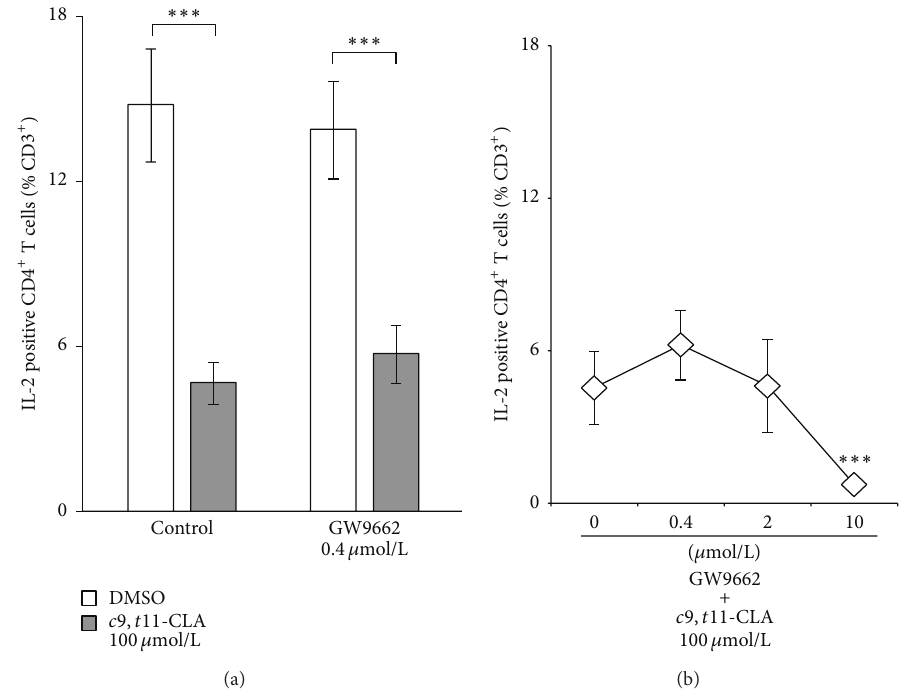
Figure 1: GW9662 exerts no effect up to 2 𝜇 mol/L and an additive effect on IL-2 inhibition in T-helper cells at 10 𝜇 mol/L. PBMC were pretreated for 30min with GW9662 before 100 𝜇 mol/L c 9, t 11-CLA was added. After 19h, cells were activated for subsequent 5 h. Intracellular IL-2 was flow cytometrically analyzed in lymphocytes gated for CD3 and CD4. ∗∗∗ 𝑃 ≤ 0.001 . Data are expressed as means ± SEM of 𝑛 = 6 (a) and 𝑛 = 5 (b).